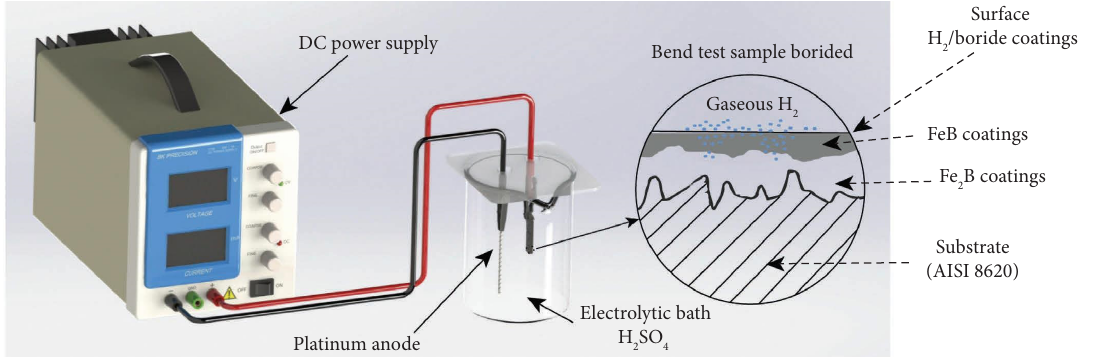
Figure 2: Schematic test setup for in situ hydrogen charging applied to 8620 steel